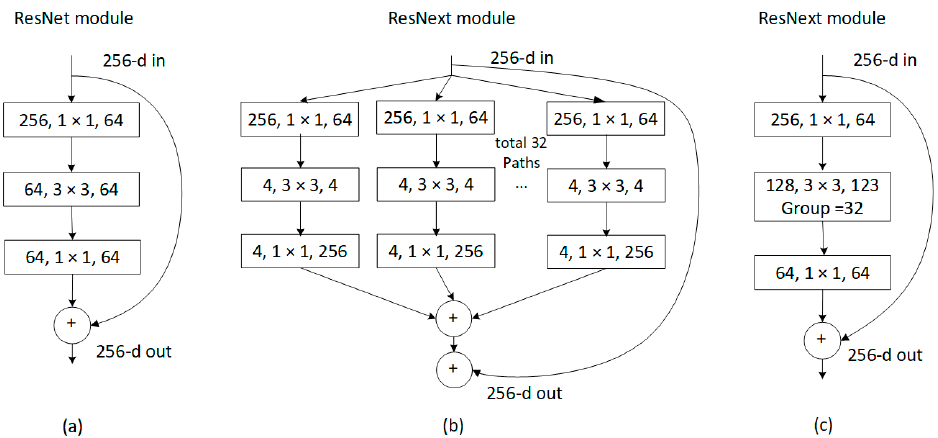
Table 2. The architecture of ResNeXt-101.